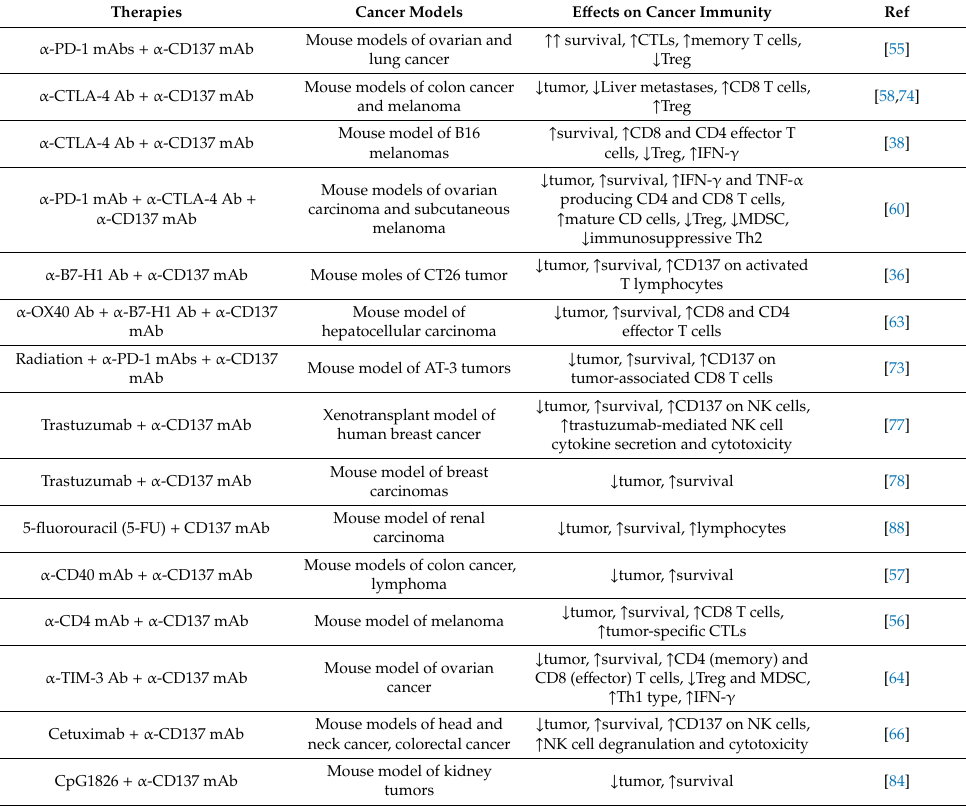
Table 3. The e ff ect of combination between anti-CD137 and other antibodies on tumor immunity.